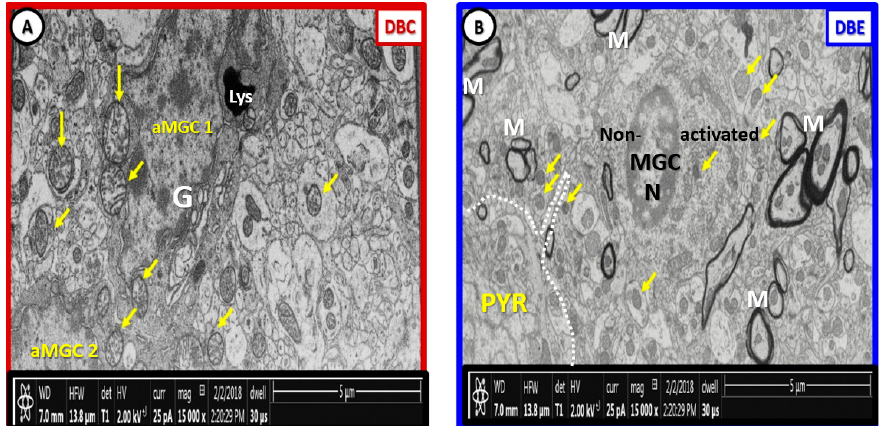
Figure 12. Labeled pre-run Supplementary Materials Video S1 fixed images comparing DBC and DBE. Panel ( A ) depicts the multiple enlarged more electron lucent aberrant mitochondria with loss of electron-dense mitochondria matrix and crista (arrows) in the diabetic DBC db / db model. In the empagliflozin-treated DBE model (panel ( B )), note that the mitochondria are electron dense and smaller (arrows), which are morphologically similar in control non-diabetic lean models as in CKC in previously-fixed images (Figure 1A–C; Figure 3A–C; Figure 7A,B; Figure 8A; Figure 9A; Figure 10A,C) and that the myelinated axons are not split and separated as in previously depicted images and (Video S1). Our observations support that the treatment with empagliflozin protects not only the aberrant Mt but also abnormal myelin remodeling in DBE models. Scale bar = 5 µ m. aMGC = activated microglia cell; Lys = lysosome; M = myelin; MGC = microglia cell; N = nucleus; PYR = pyramidal neuron